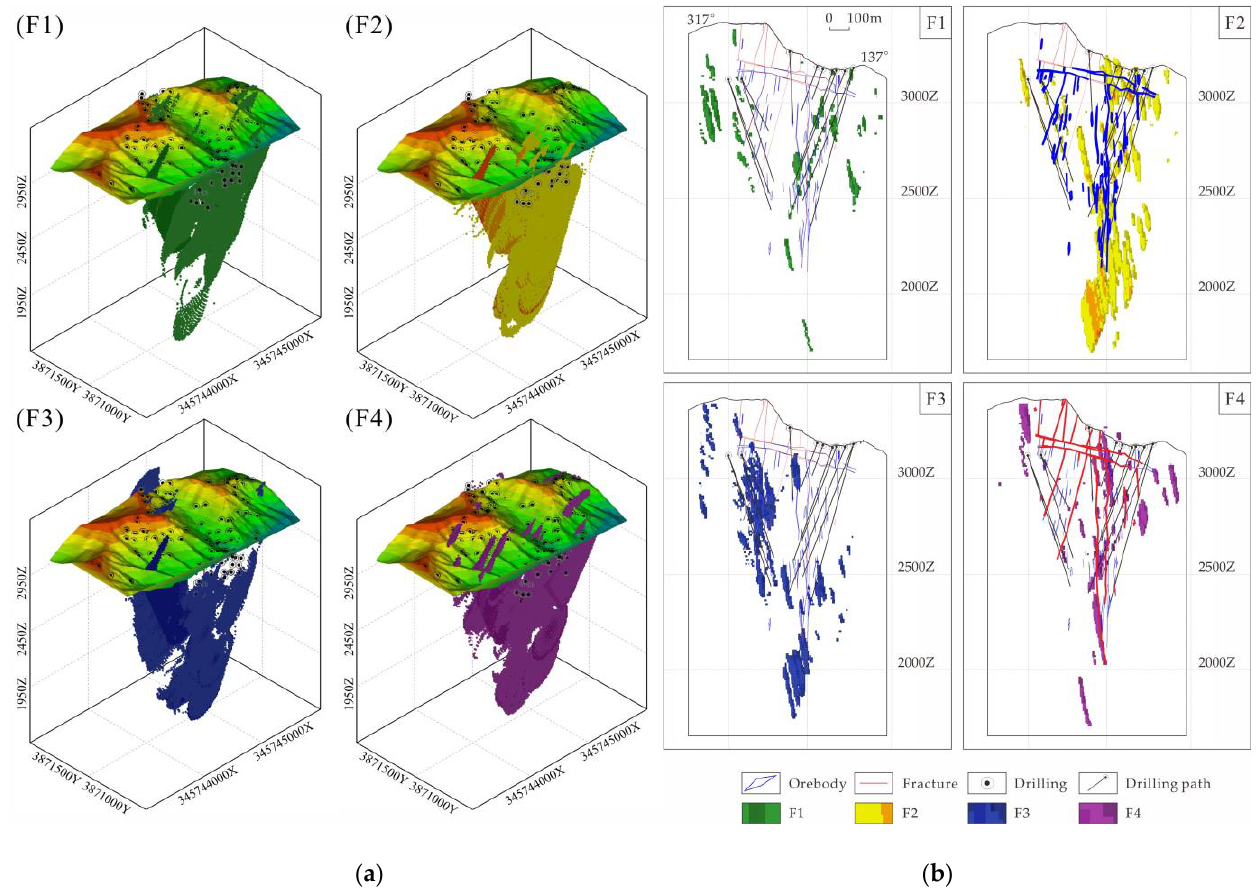
Figure 14. ( a ) Factor scores distribution of each factor. ( b ) Distribution of factor scores in the 85# exploration profile.